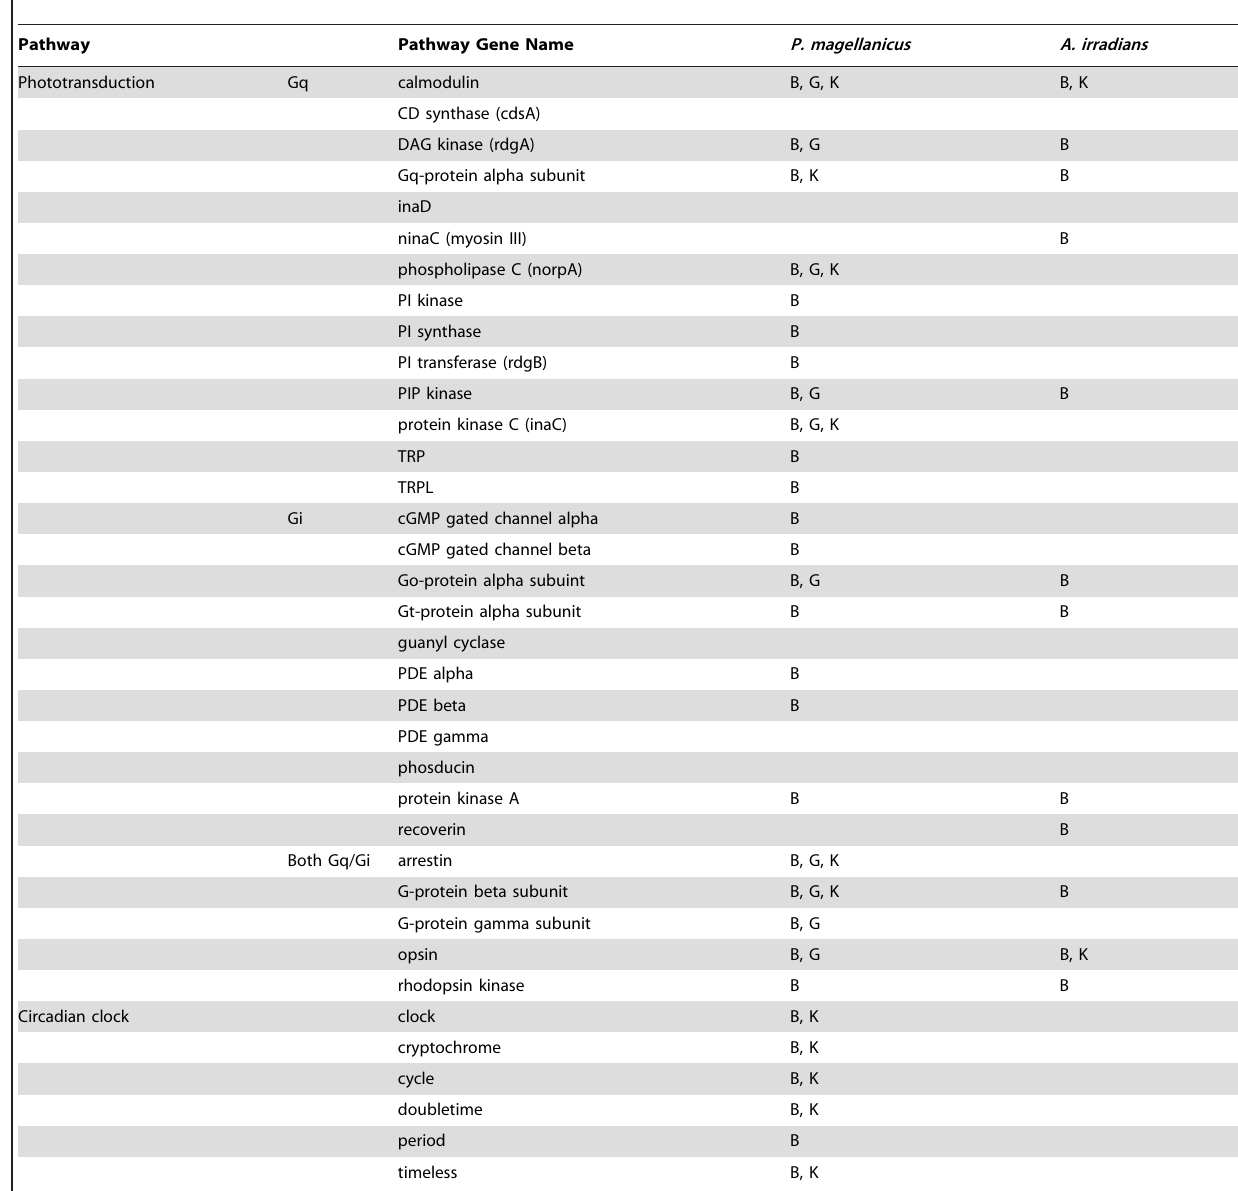
Table 2. Presence of key phototransduction and circadian clock genes in scallop eye transcriptomes.